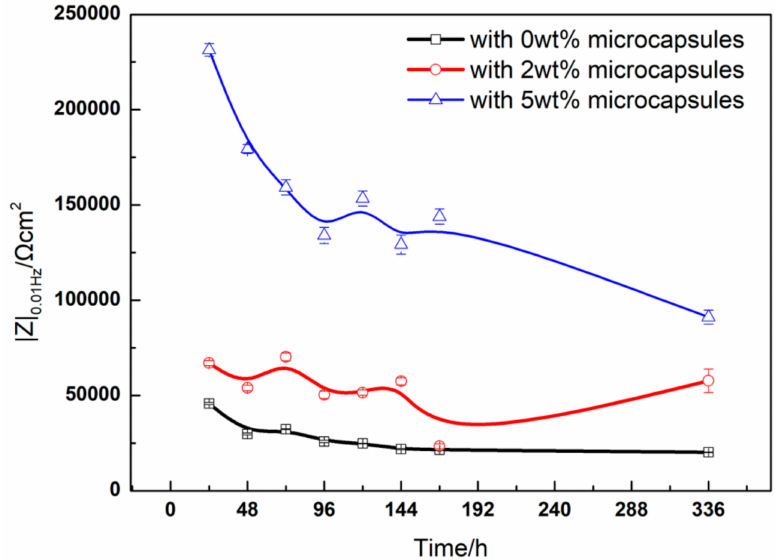
Figure 9. Impedance modulus (f = 0.01 Hz) of the scratched coating after immersion in